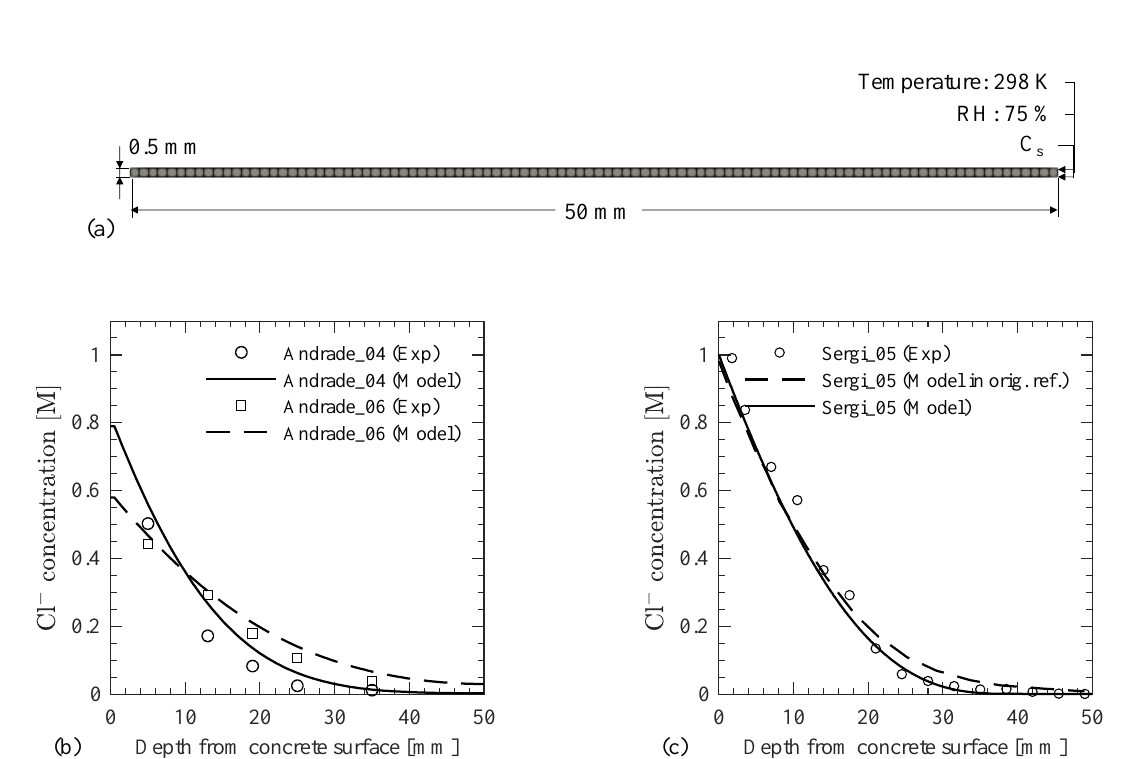
Figure 8. ( a ) Numerical model for validation study, and comparison of the simulation results with experimental data from ( b ) Andrade et al. [11] and ( c ) Sergi et al. [43].